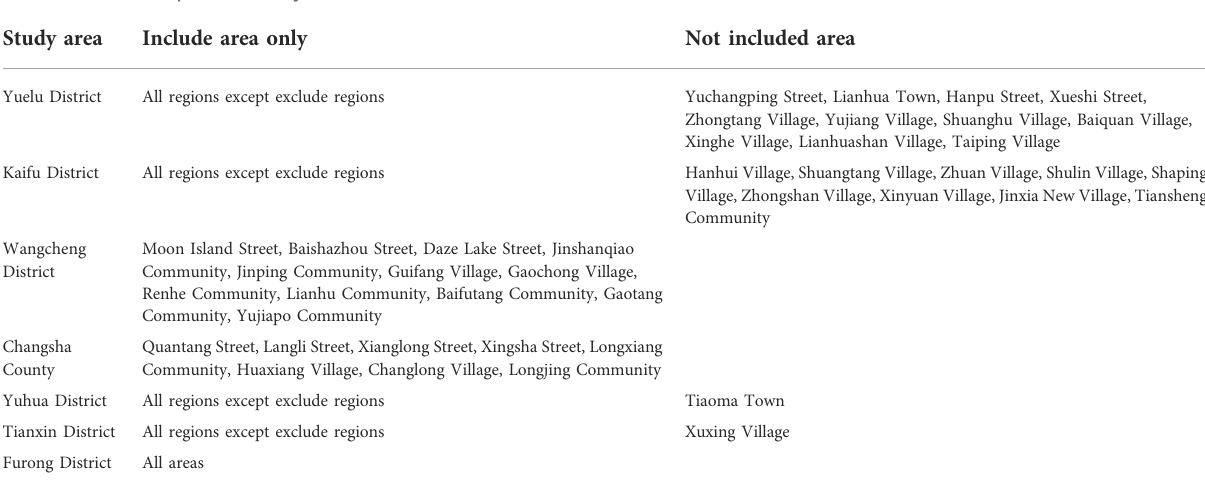
FIGURE 1 Research area.